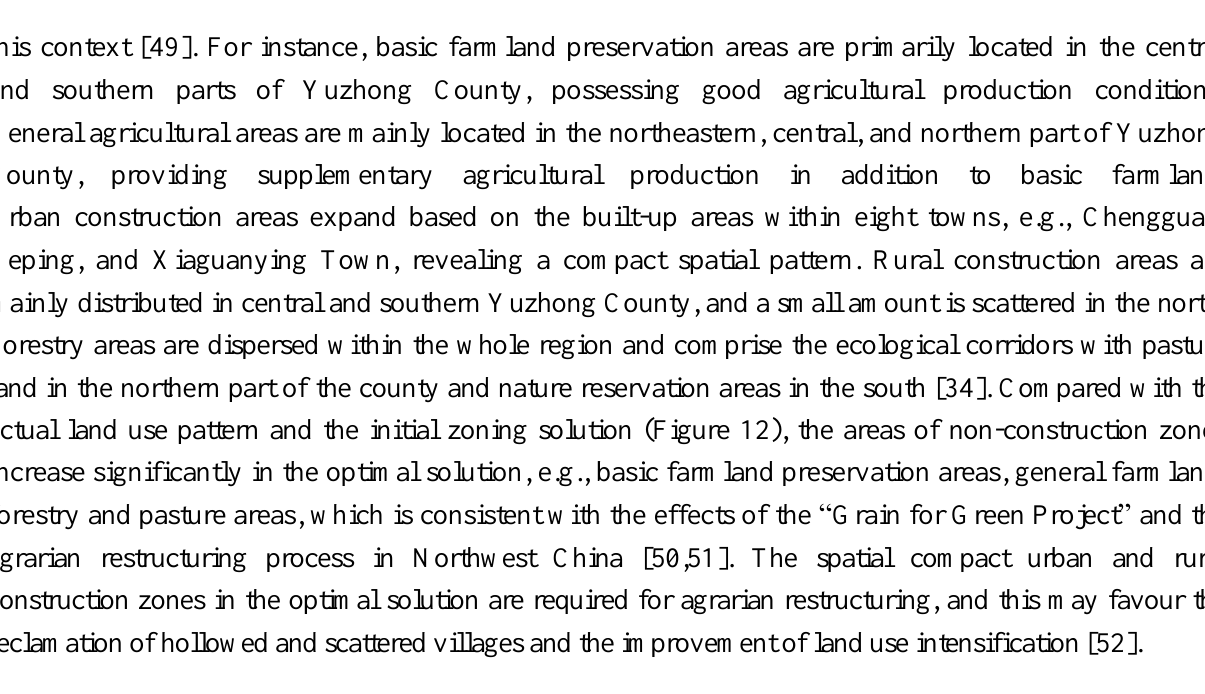
Figure 12. Comparative analysis between the optimal, the initial solutions and the actual land use pattern for each zone: ( a ) BFPA; ( b ) GAL; ( c ) FL; ( d ) PL; ( e ) UCL; ( f )